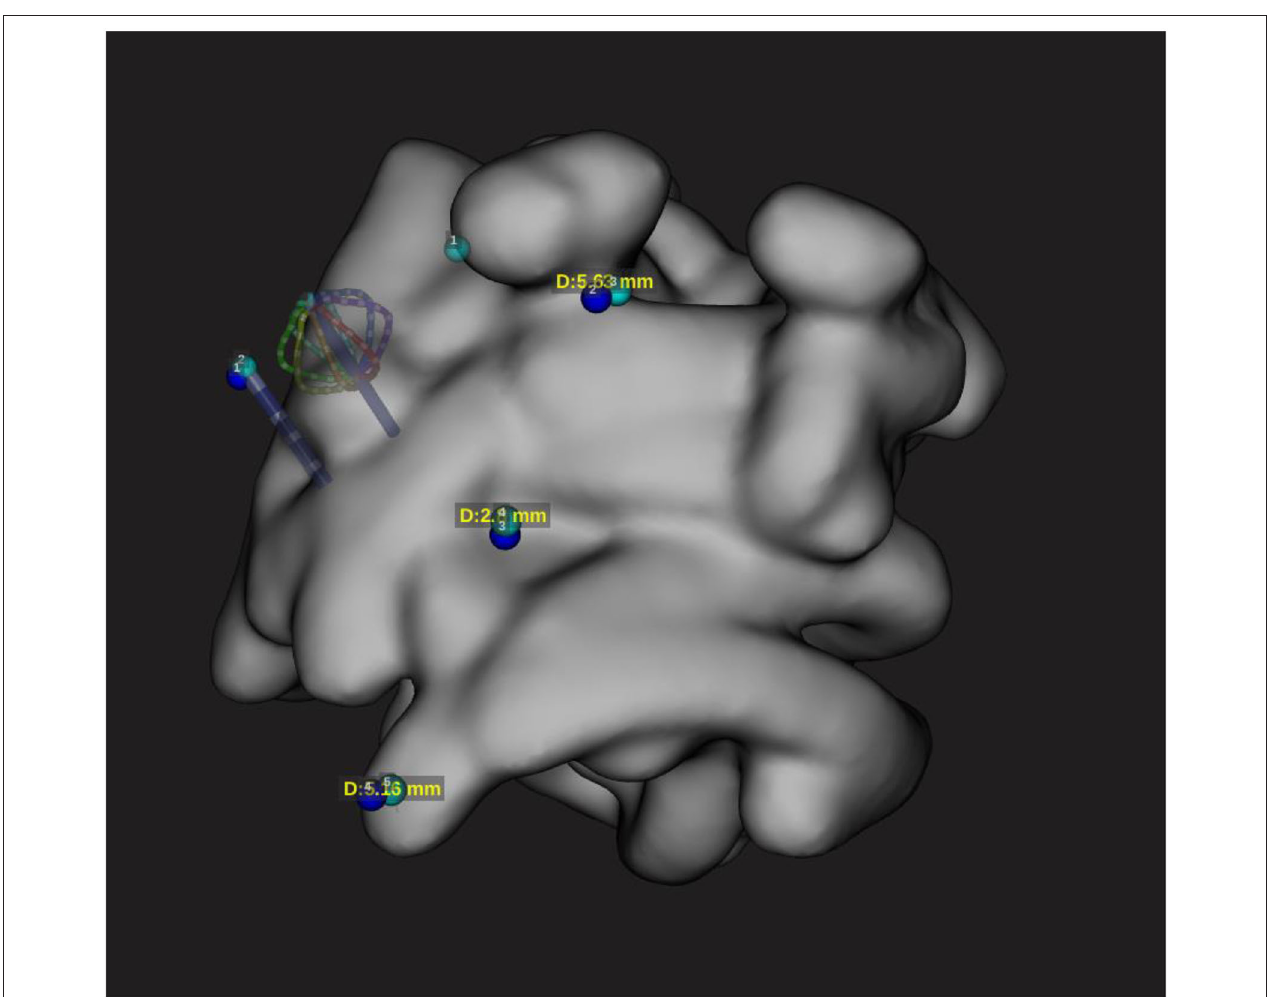
FIGURE 4 | Localization accuracy with minimal deviation according to configuration 3.2. The catheter positioned on the reference points is represented on the EAM with minimal difference to the reference sensor-enabled